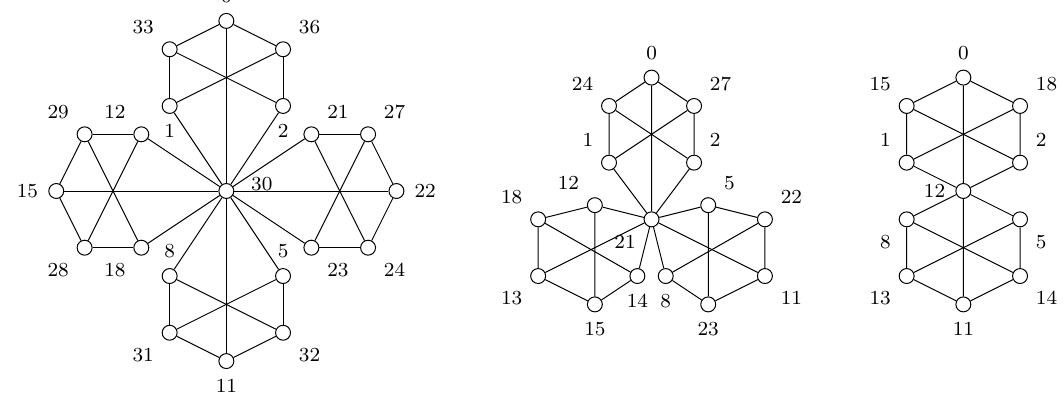
Figure 1: α -labeling of the one-point union of four, three, and two copies of K